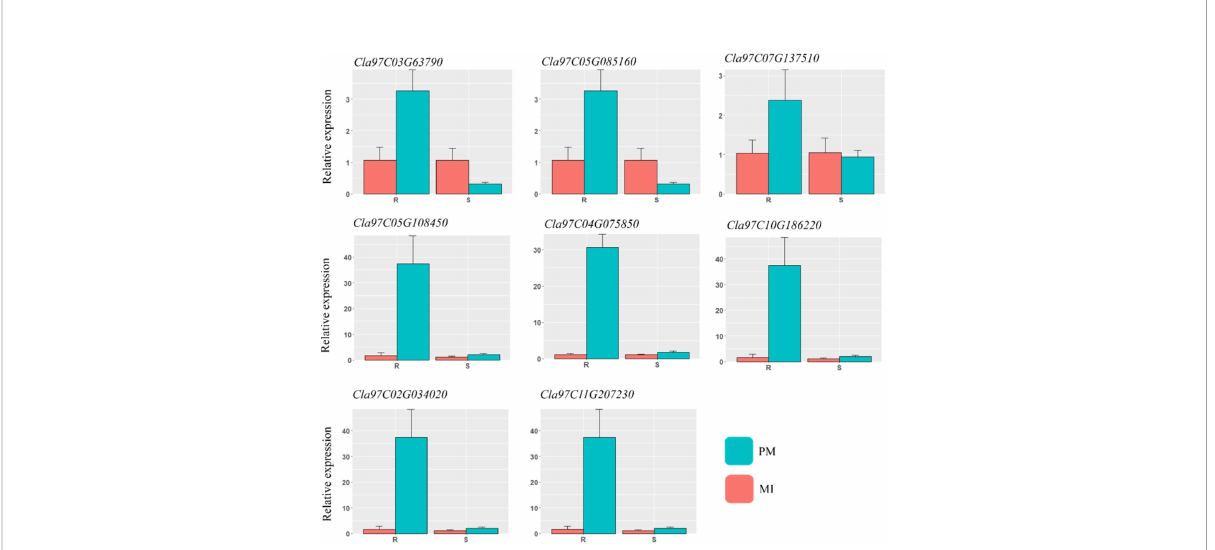
FIGURE 9 qRT-PCR validation of the various DEGs identi fi ed in different defense related pathways. The important candidate genes were selected and analyzed in contrasting watermelon lines mock inoculated (MI) and powdery mildew inoculated